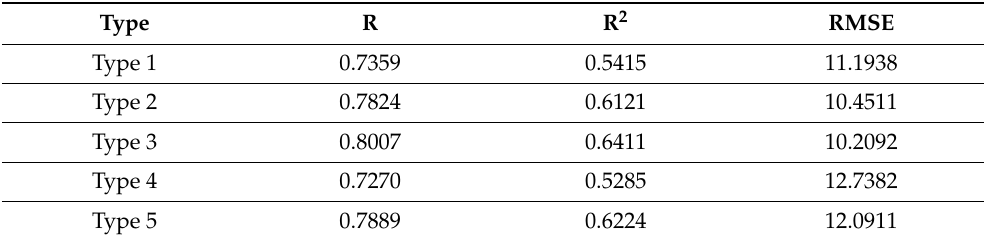
Table 11. Regression analysis results of equations for predicting the ultimate axial strain of the SMA-confined concrete cylindrical